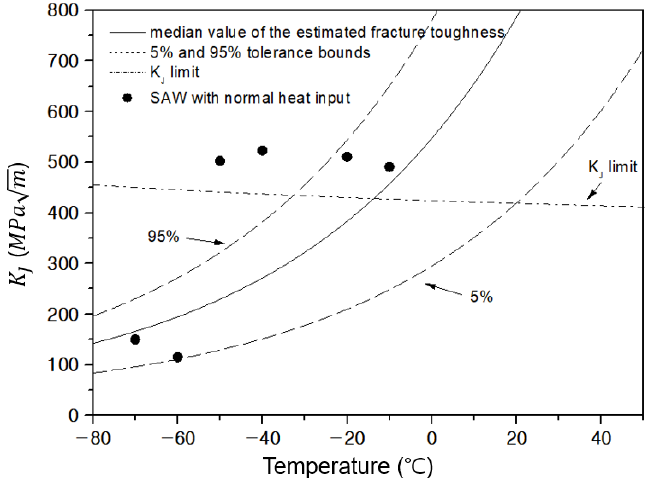
Figure 15. Master curve for SAW, normal heat input condition with CTOD test results.